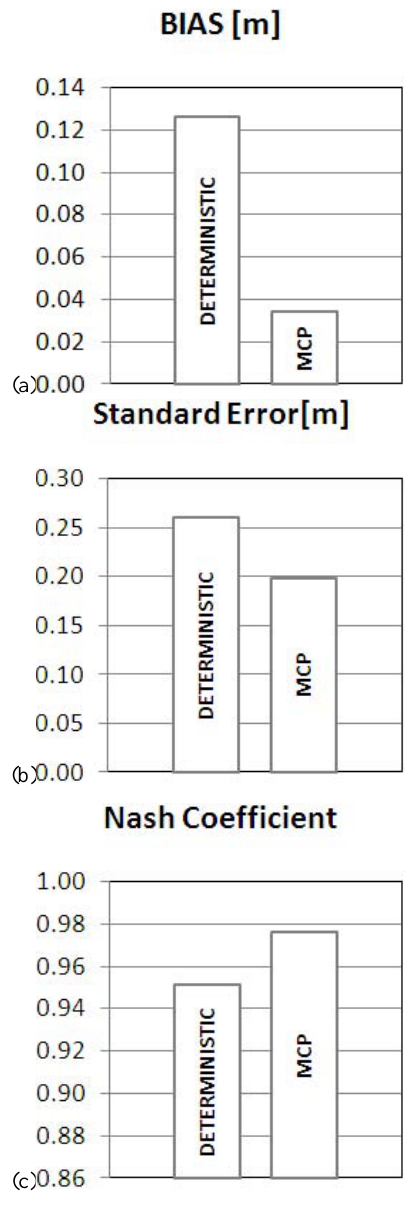
Fig. 6. Comparison between the evaluation indexes for the deter- ministic model and those obtained from the PU expected value pro- vided by the MCP for the entire validation period. (a) Bias; (b) Standard Error; (c) Nash-Sutcliffe coefficient.